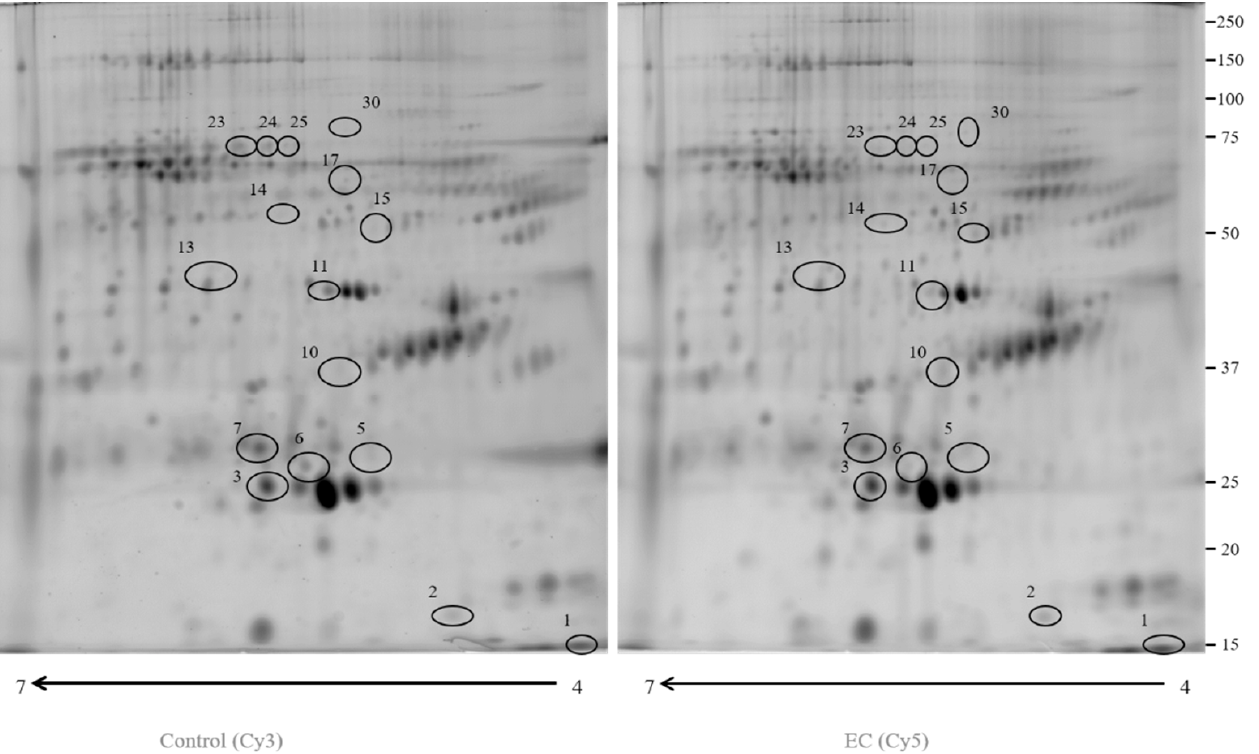
Figure 1. A 2D-DIGE map of depleted serum from control serum and endometrial serum. IPG strips 4–7 were used for the first dimension and 10% SDS-PAGE was utilized for the second dimension. The numbered circles indicate the differently abounding spots.